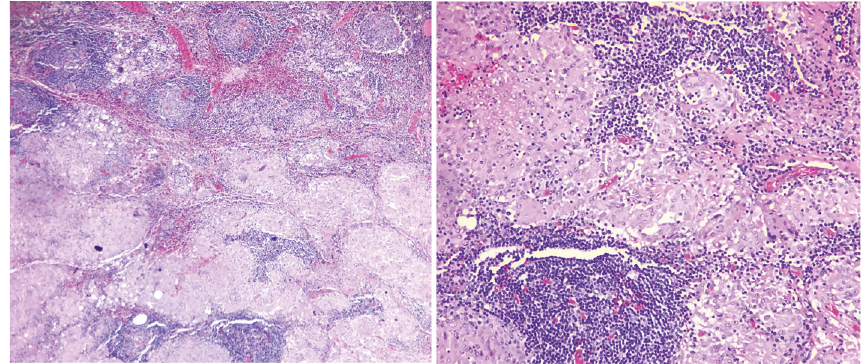
Figure 2: H&E stain of granulomatous lymph node at low and intermediate power.